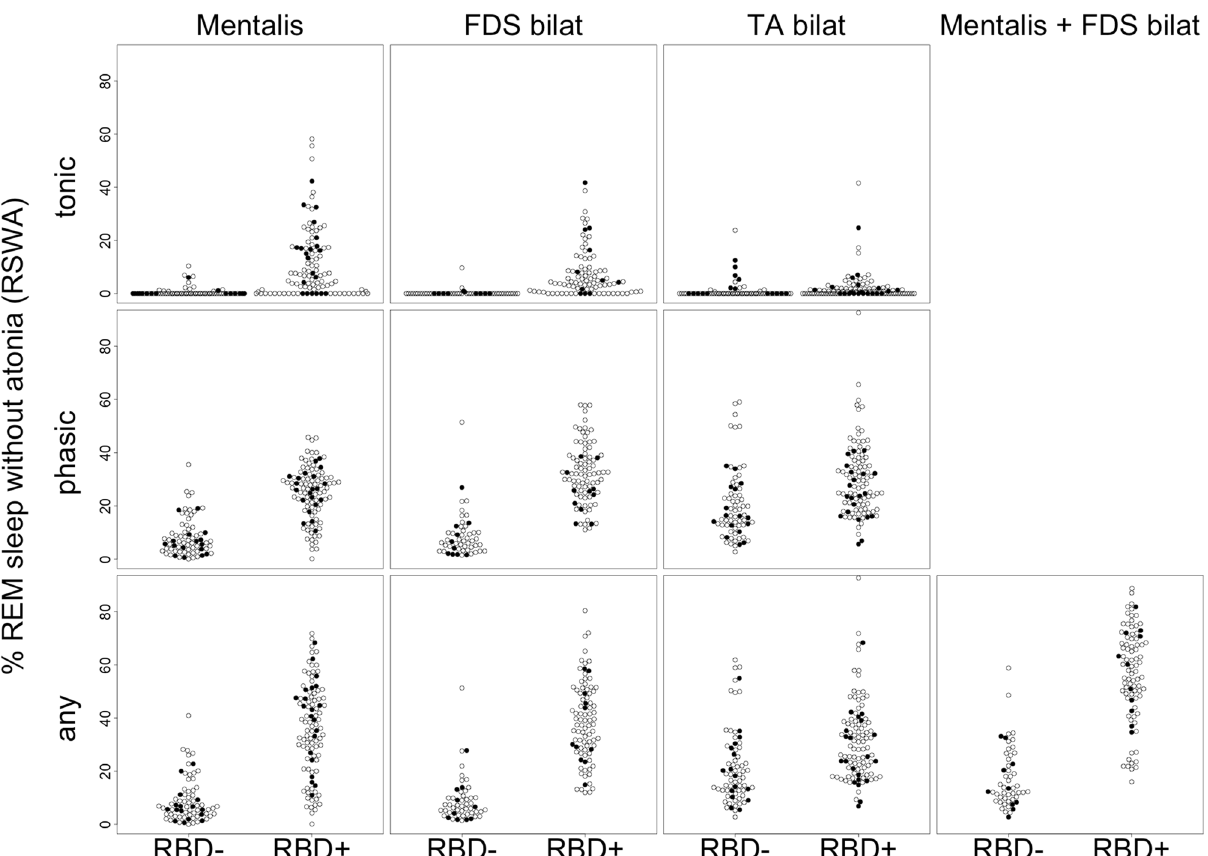
Figure 4. Dot plots of individual tonic (upper row), phasic (middle row), and (any) percentage of rapid eye movement (REM) sleep without atonia after removal of arousals only in mentalis EMG and combination of FDS and TA EMG channels of both sides as well as the combination of mentalis EMG and combined FDS EMG channels. Subjects without RBD (RBD-, patients with Parkinson’s disease marked as black dots) are presented on the left, and subjects with RBD on the right (RBD+). FDS flexor digitorum superficialis muscle, TA tibialis anterior muscle, R right, L left.